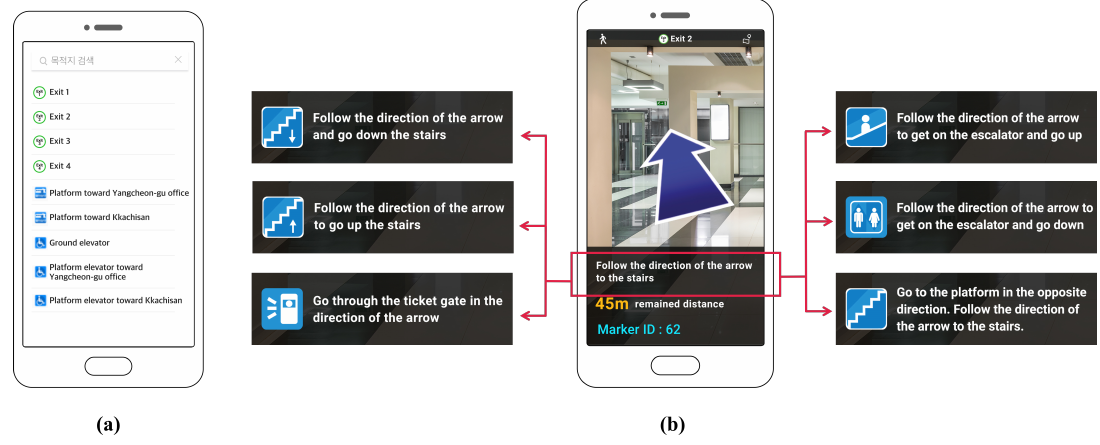
Figure 6. AR-based navigation application of HMIPS: ( a ) destination setting; ( b ) destination guide.